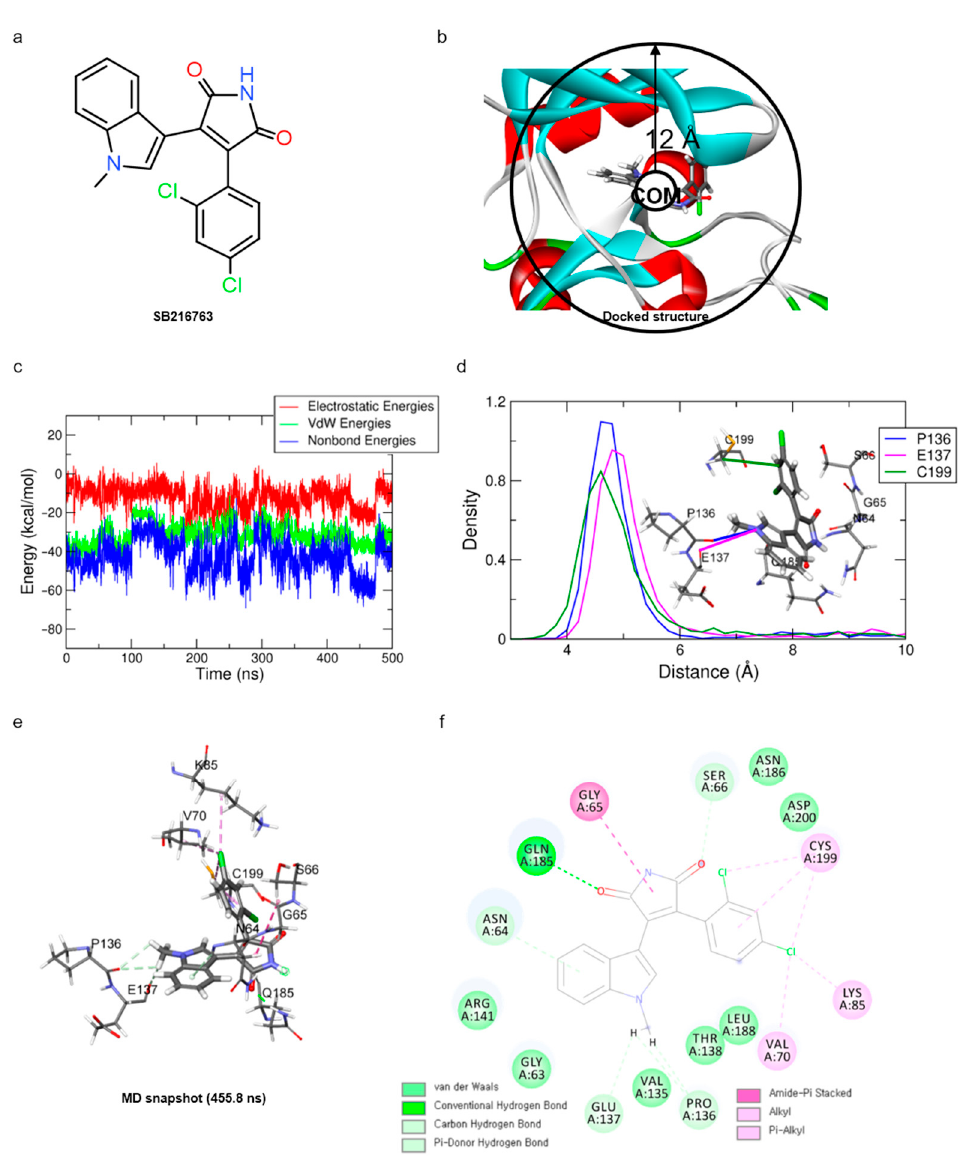
Figure 1. Results of MD simulation for reference compound SB with GSK3 β protein. ( a ) Chemical structure of reference compound SB216763. ( b ) Diagram of upper-wall restraint to keep ligand inside the binding site. ( c ) Time traces of protein–ligand non-bonded energies (blue line), which are the sum of electrostatic (red) and vdW (green) energies for SB216763 bound systems. ( d ) Distance distribution of SB216763 with three significantly interacting residues during the final 200 ns. The blue line represents the distance between ligand:N1 and P136:O. The magenta and green lines represent the distance of ligand:N1 with E137:O and ligand:C17 with C199:CB, respectively. The SB216763 is represented as a stick model. ( e ) Binding mode of SB216763 with the ATP-binding site in the GSK3 β protein. ( f ) A 2D diagram for the binding mode.